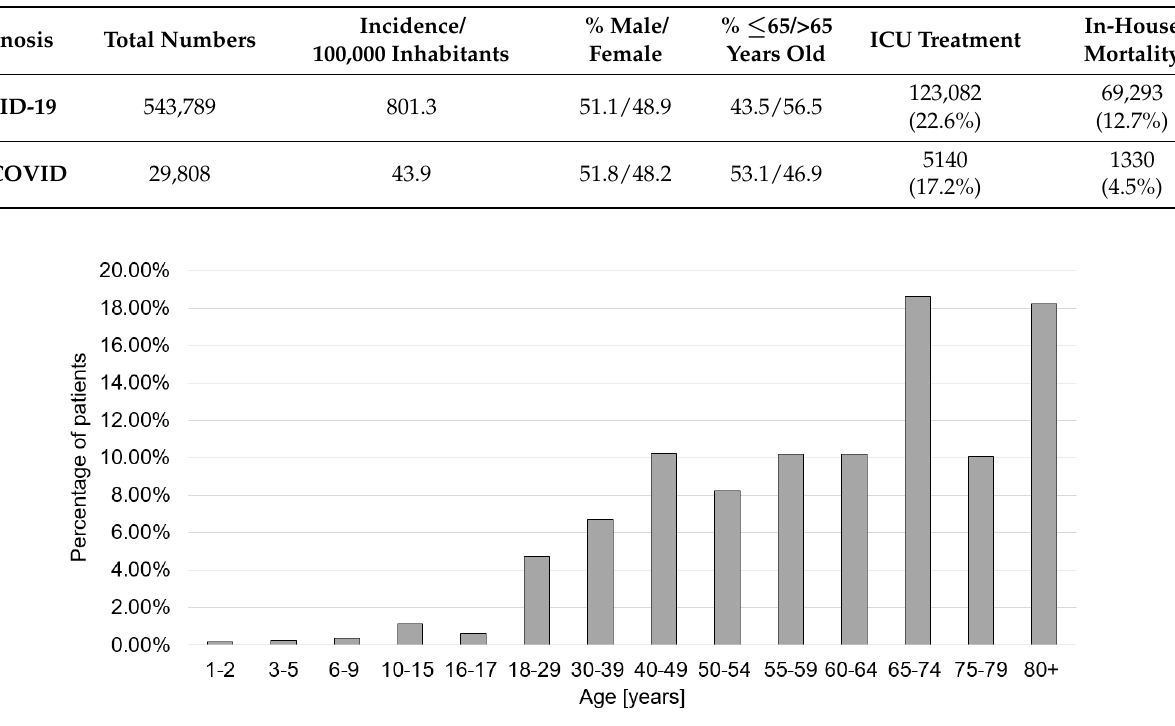
Figure 1. Age distribution of Post-COVID syndrome patients.